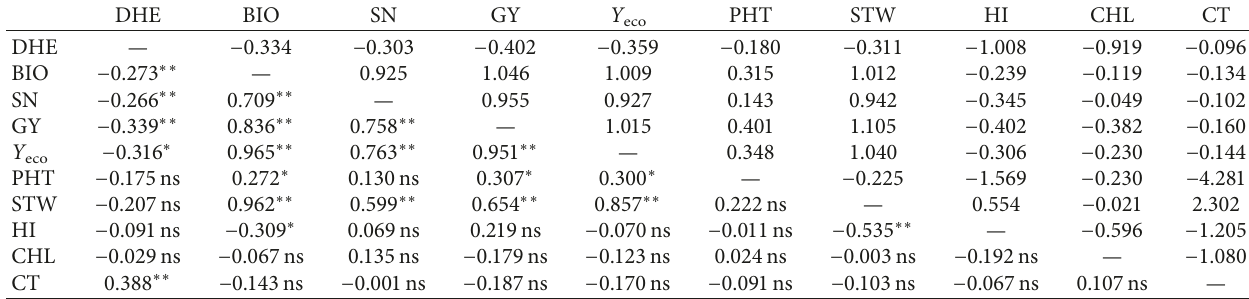
Table 5: Phenotypic (below diagonal) and genotypic (above diagonal) correlation coefficients for ten characters of 56 genotypes of durum